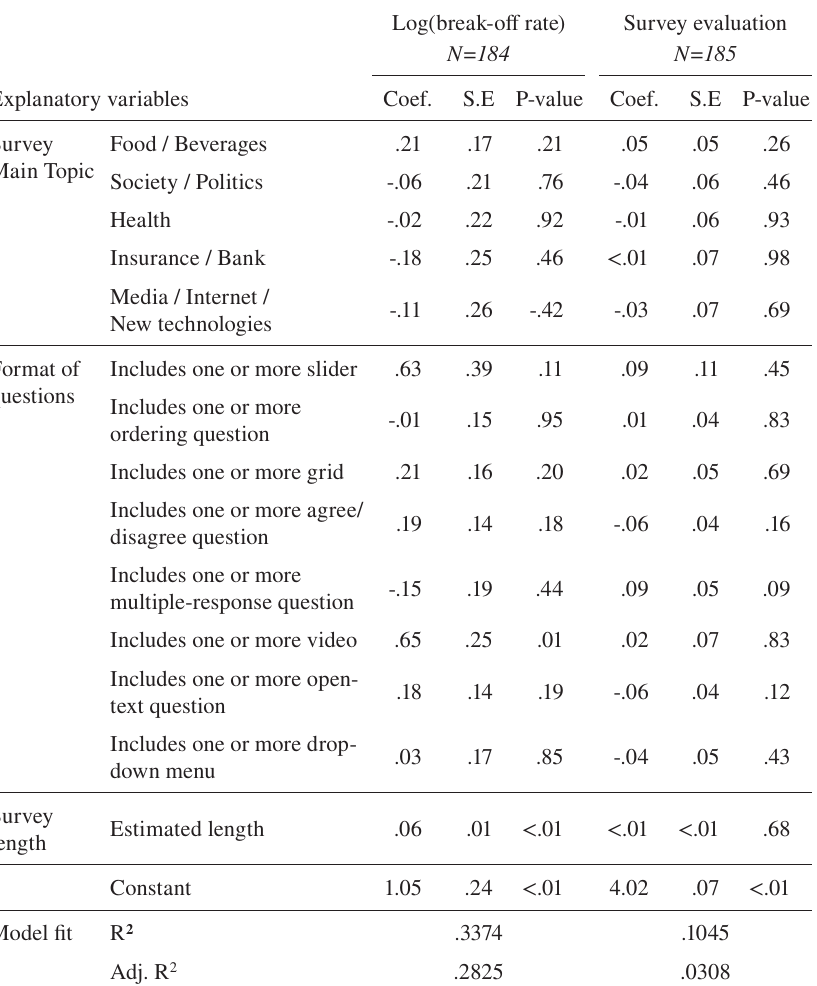
Table 11 Regressions of log(break-off rate) and of survey evaluation on survey